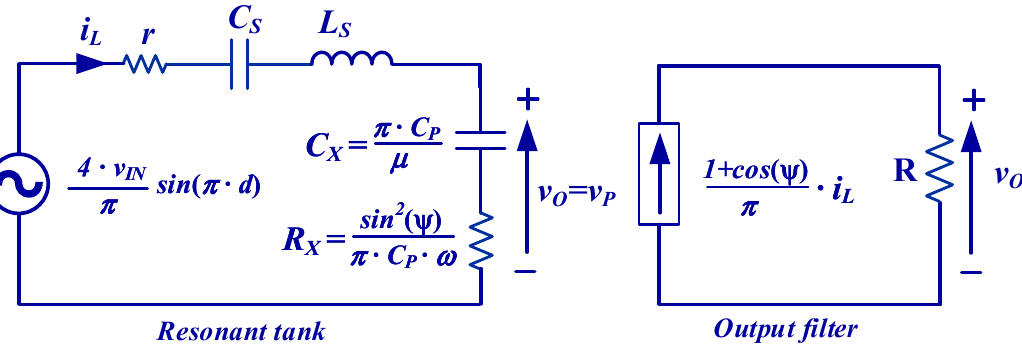
Figure 3. Equivalent circuit of the topology according to [25,33]. Waveforms are expressed as amplitudes.